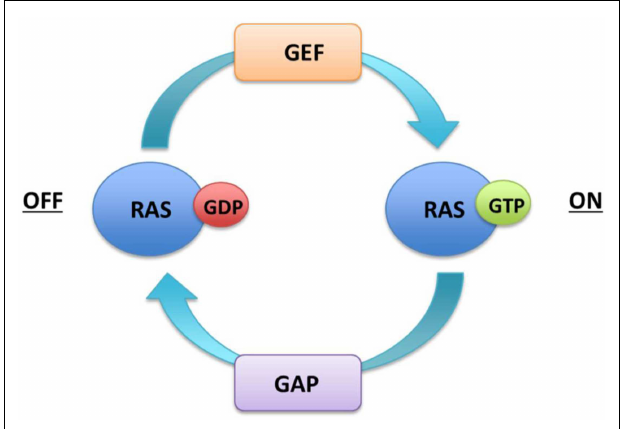
FIGURE 1 | Regulation of Ras activity .